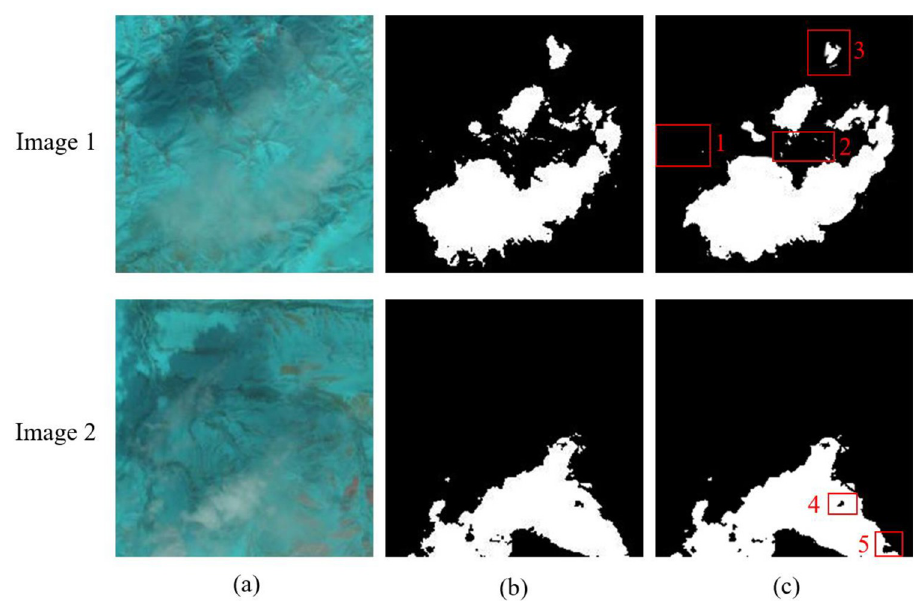
Fig 8. Bad samples in segmentation results, (a) are the original image, (b) are the Ground-truth, (c) are the segmentation result of the proposed